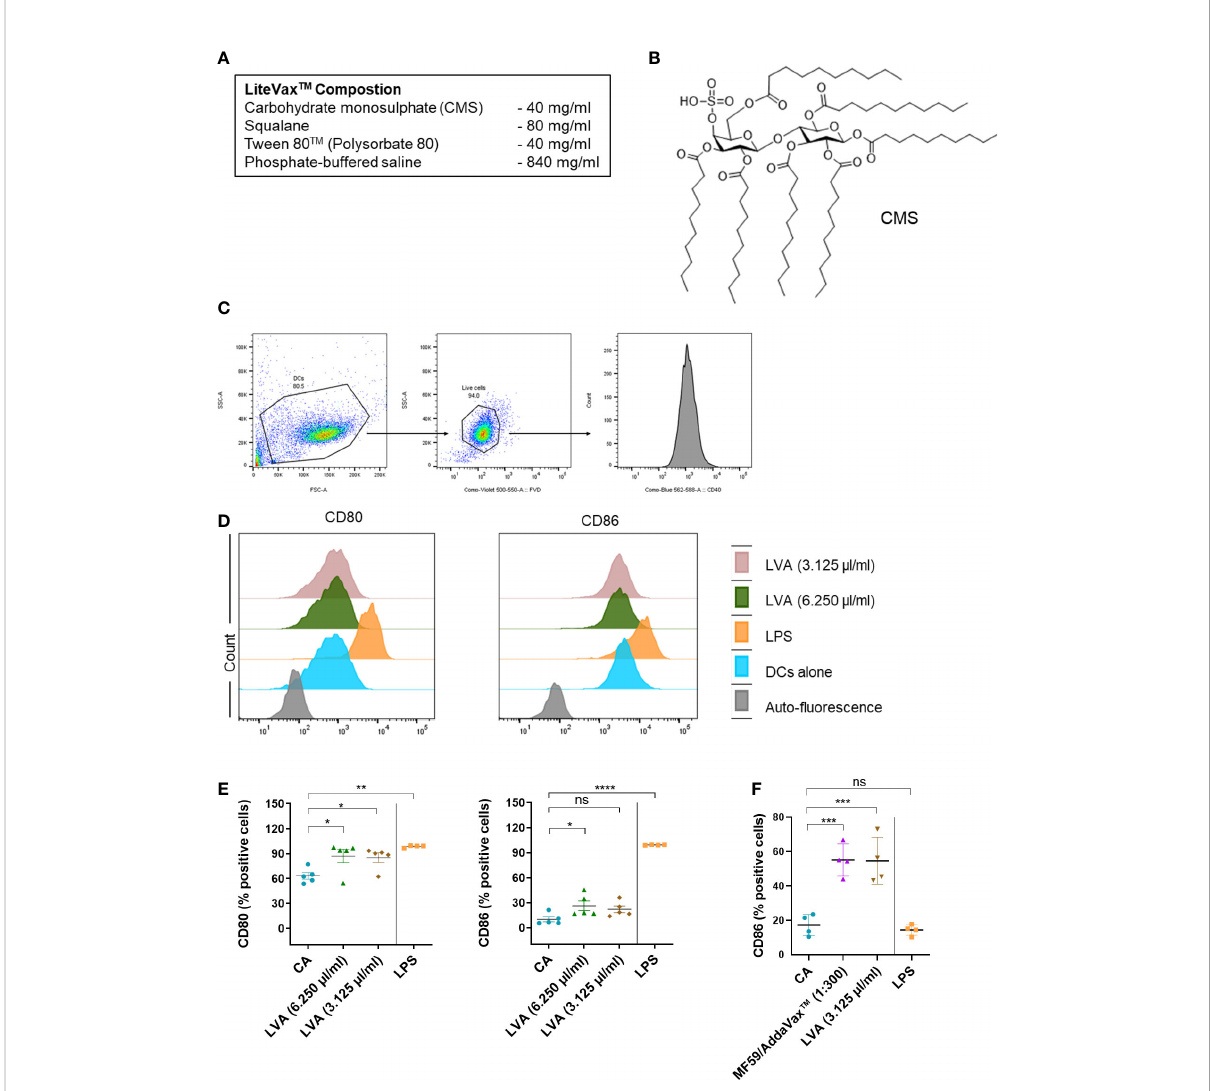
FIGURE 1 Immunological mechanism of action of LiteVax ™ (LVA) adjuvant on antigen presenting cells. (A) Composition of LVA. (B) Structure of active constituent of LVA, CMS: Maltose 4 ’– monosulphate 1,2,3,6,2 ’ ,3 ’ ,6 ’– heptadecanoic acid ester. (C – E) Effect of LVA on dendritic cell maturation. Monocytes were isolated from human peripheral blood mononuclear cells. Monocytes were cultured with granulocyte – macrophage colony – stimulating factor (GM – CSF, 1000 IU/10 6 cells) and IL – 4 (500 IU/10 6 cells) in RPMI 1640 complete medium (10% fetal calf serum and 1% penicillin – streptomycin) for 5days to obtain immature dendritic cells. Immature dendritic cells (0.5x10 6 cells/ml) were seeded in the 24 – well plate and left untreated (CA) or treated with LPS (100 ng/ml, a positive control), LVA (3.125 µl/ml, which contains 125 µg of CMS, or 6.250 µl/ml, which contains 250 µg of CMS) for 48 h. Gating strategy is presented (C) . Representative histograms (D) with scatter plots (E) of data presented as mean ± SEM (n=4 – 5) values of expression (% positive cells) of CD80 and CD86. (F) Effect of LVA on monocytes activation. Monocytes were cultured in RPMI complete medium without GM – CSF/IL – 4 and were either not treated or treated with LPS (100 ng/ml), AddaVax ™ /MF59 (1:300 v/v, a squalene – based oil – in – water nano – emulsion as a control), LVA (3.125 µl/ml) for 48 h. After incubation, cells were subjected to phenotyping by fl ow cytometry and the expression of CD86 (% positive cells) was presented as mean ± SEM (n=4 donors). Statistical signi fi cance as determined by one – way ANOVA with Dunnett ’ s multiple comparisons post – test. * P < 0.05, ** P < 0.01, *** P < 0.001, **** P < 0.0001, ns, not signi fi cant. CA, cells alone, LPS,